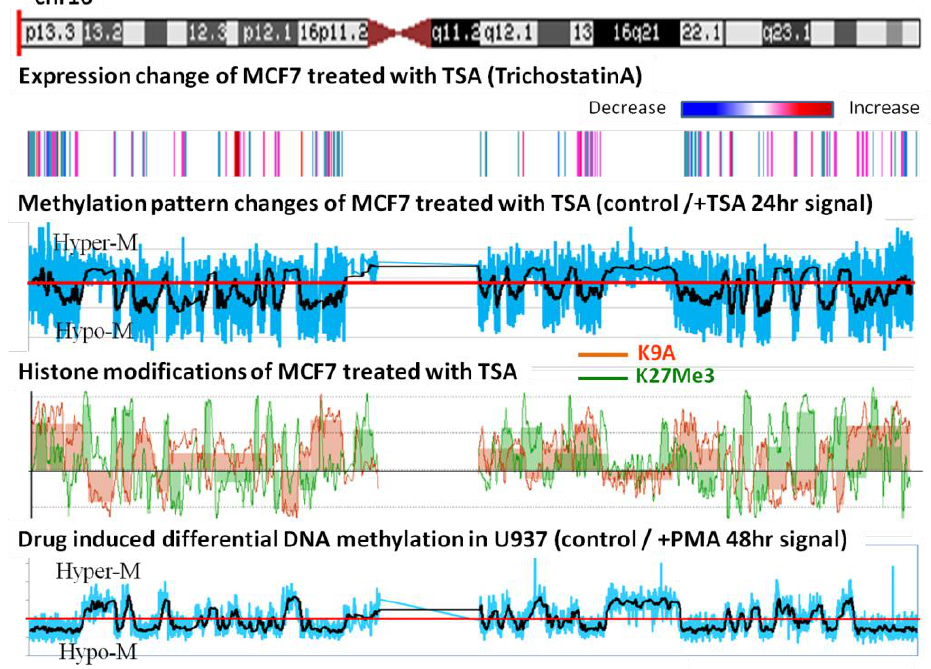
Figure 6. An example of a highly expressed gene with promoter hypomethylation and gene body hypermethylation. Top panel is the gene map of PTGES3 with the expression number in parenthesis. The lower panel is the level of methylation as determined by bisulfite sequencing; the transcription is from right to